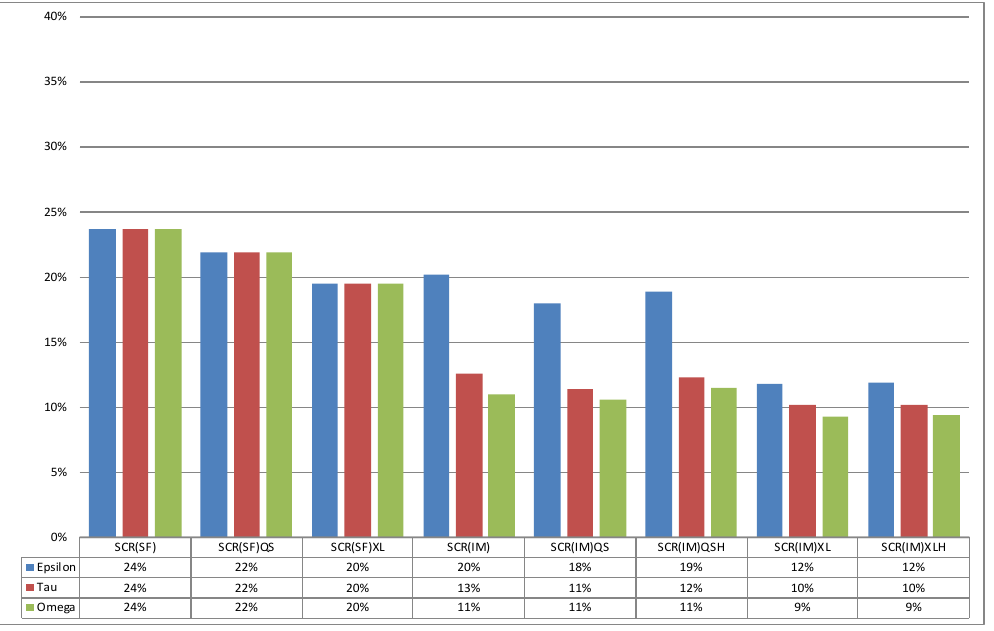
Figure 8. Motor portfolio mix: ratio SCR/B.